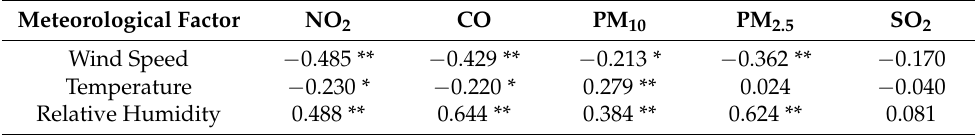
Table 3. Correlation analysis between the air pollutants and meteorological